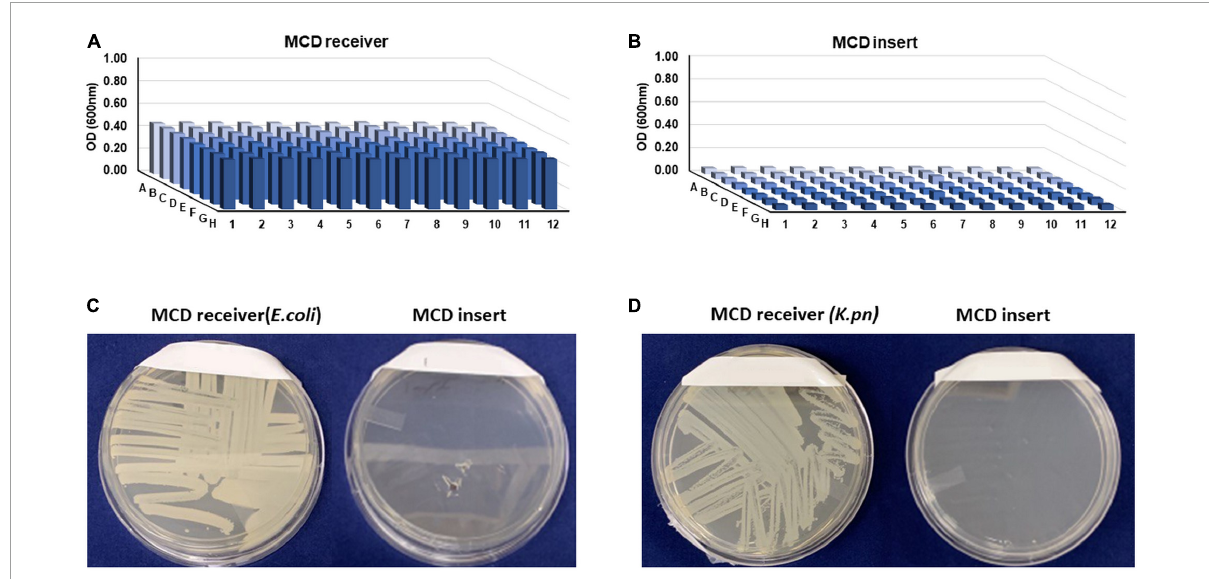
FIGURE3 Sterility testing of the MCD insert (upper, analytical chamber) following an 8-h incubation of the MCD receiver seeded with bacteria. Bacterial cell densities (OD 600 ) in the MCD receiver (A) and MCD insert (B) show that growth only took place in the receiver and not the insert. To further validate sterility of the insert, the MCD receiver and insert samples were streaked on agar plates and incubated overnight (C,D)